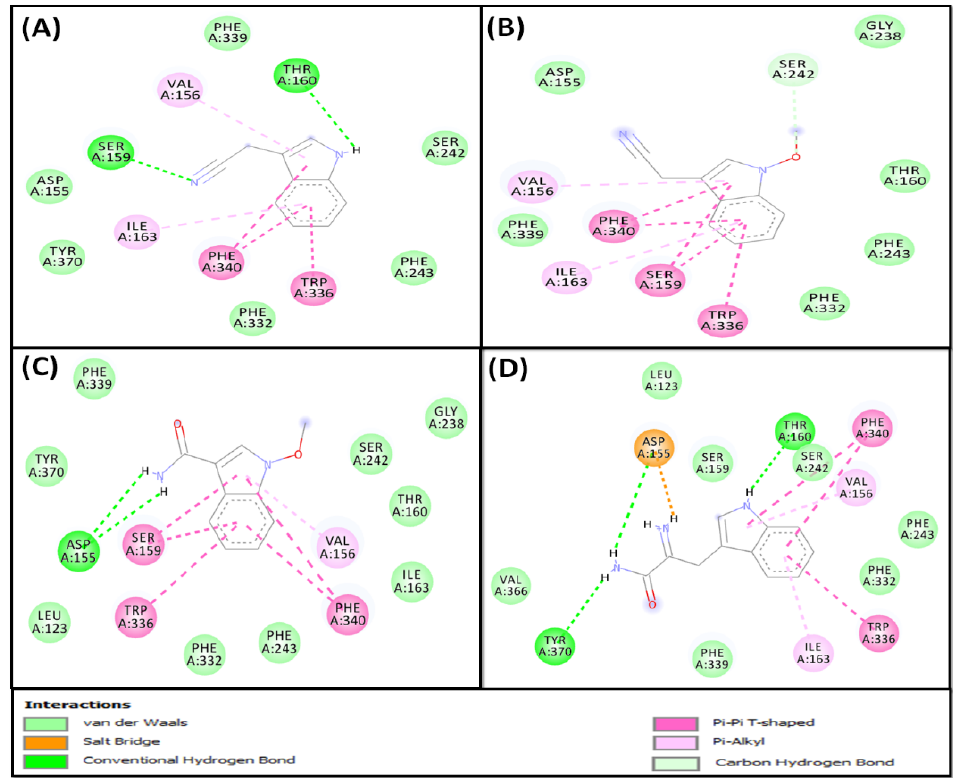
Figure 7. Molecular docking of isolated SI indole compounds and resperidone with 5-HT 2A . ( A ) Two-dimensional representation of ligands binding to the protein; ( B ) three-dimensional representation of ligands binding at the cavity of the protein; and ( C ) molecular interaction and the amino acid residues involved in stabilizing resperidone (control) and 5-HT 2A complex formation.